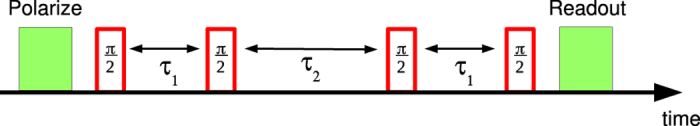
Pulse sequence for the two dimensional ESEEM measurement used in our experiments.See text for detailed description.